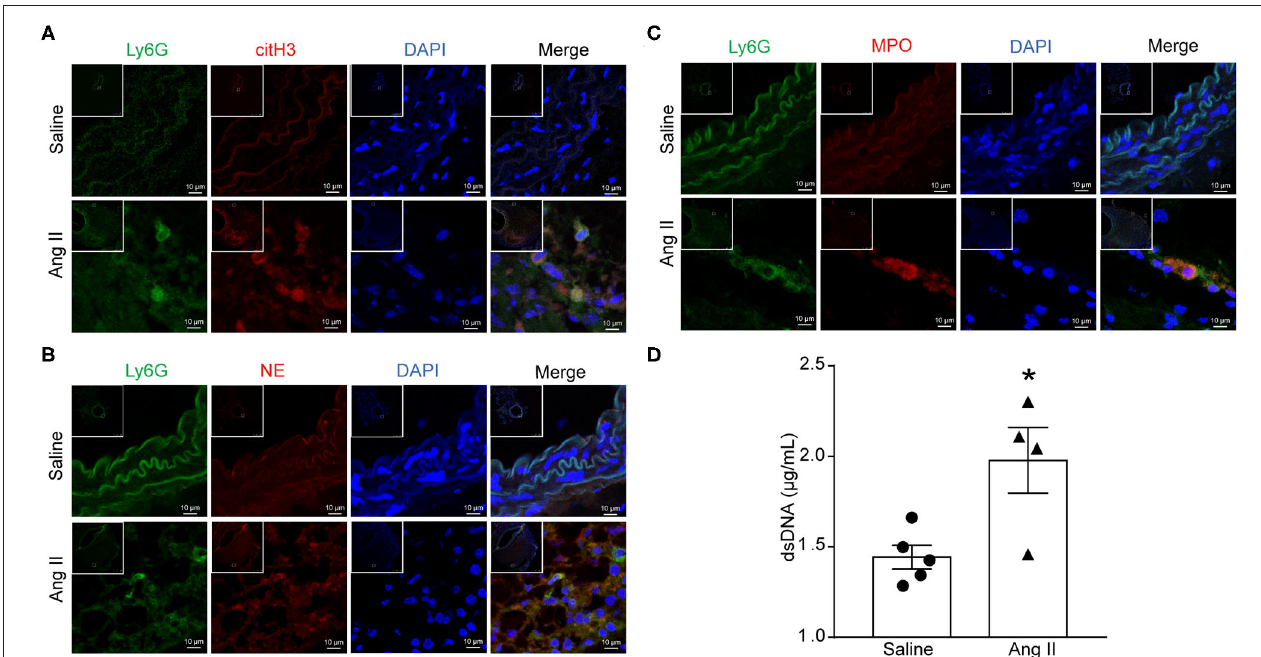
FIGURE 1 | Ang II induced NET formation in vivo . ApoE − / − mice were infused with saline or 1,000 ng/kg/min Ang II for 28 days. (A–C) Immunofluorescence analysis of mouse abdominal aortas for NET markers citH3 (red), NE (red), and MPO (red) with neutrophil marker Ly6G (green). Nuclei were stained with DAPI. (D) Measurement of dsDNA in the serum from saline or Ang II (1,000 ng/kg/min) infused ApoE − / − mice. n = 5/saline group, n = 4/Ang II group, * p < 0.05. Statistical significance was analyzed by the unpaired t -test.